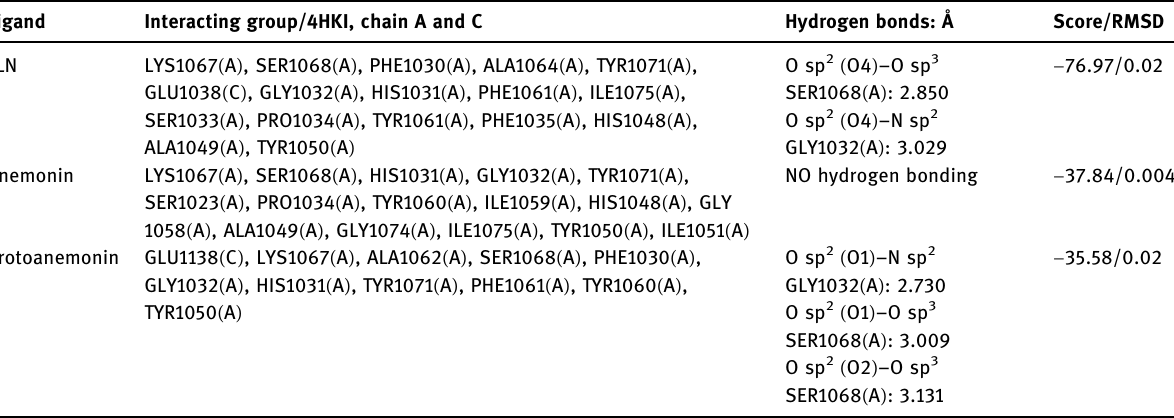
Table 4: Results of molecular docking study on human tankyrase 2, TNKS2 Ligand Interacting group/4HKI, chain A and C